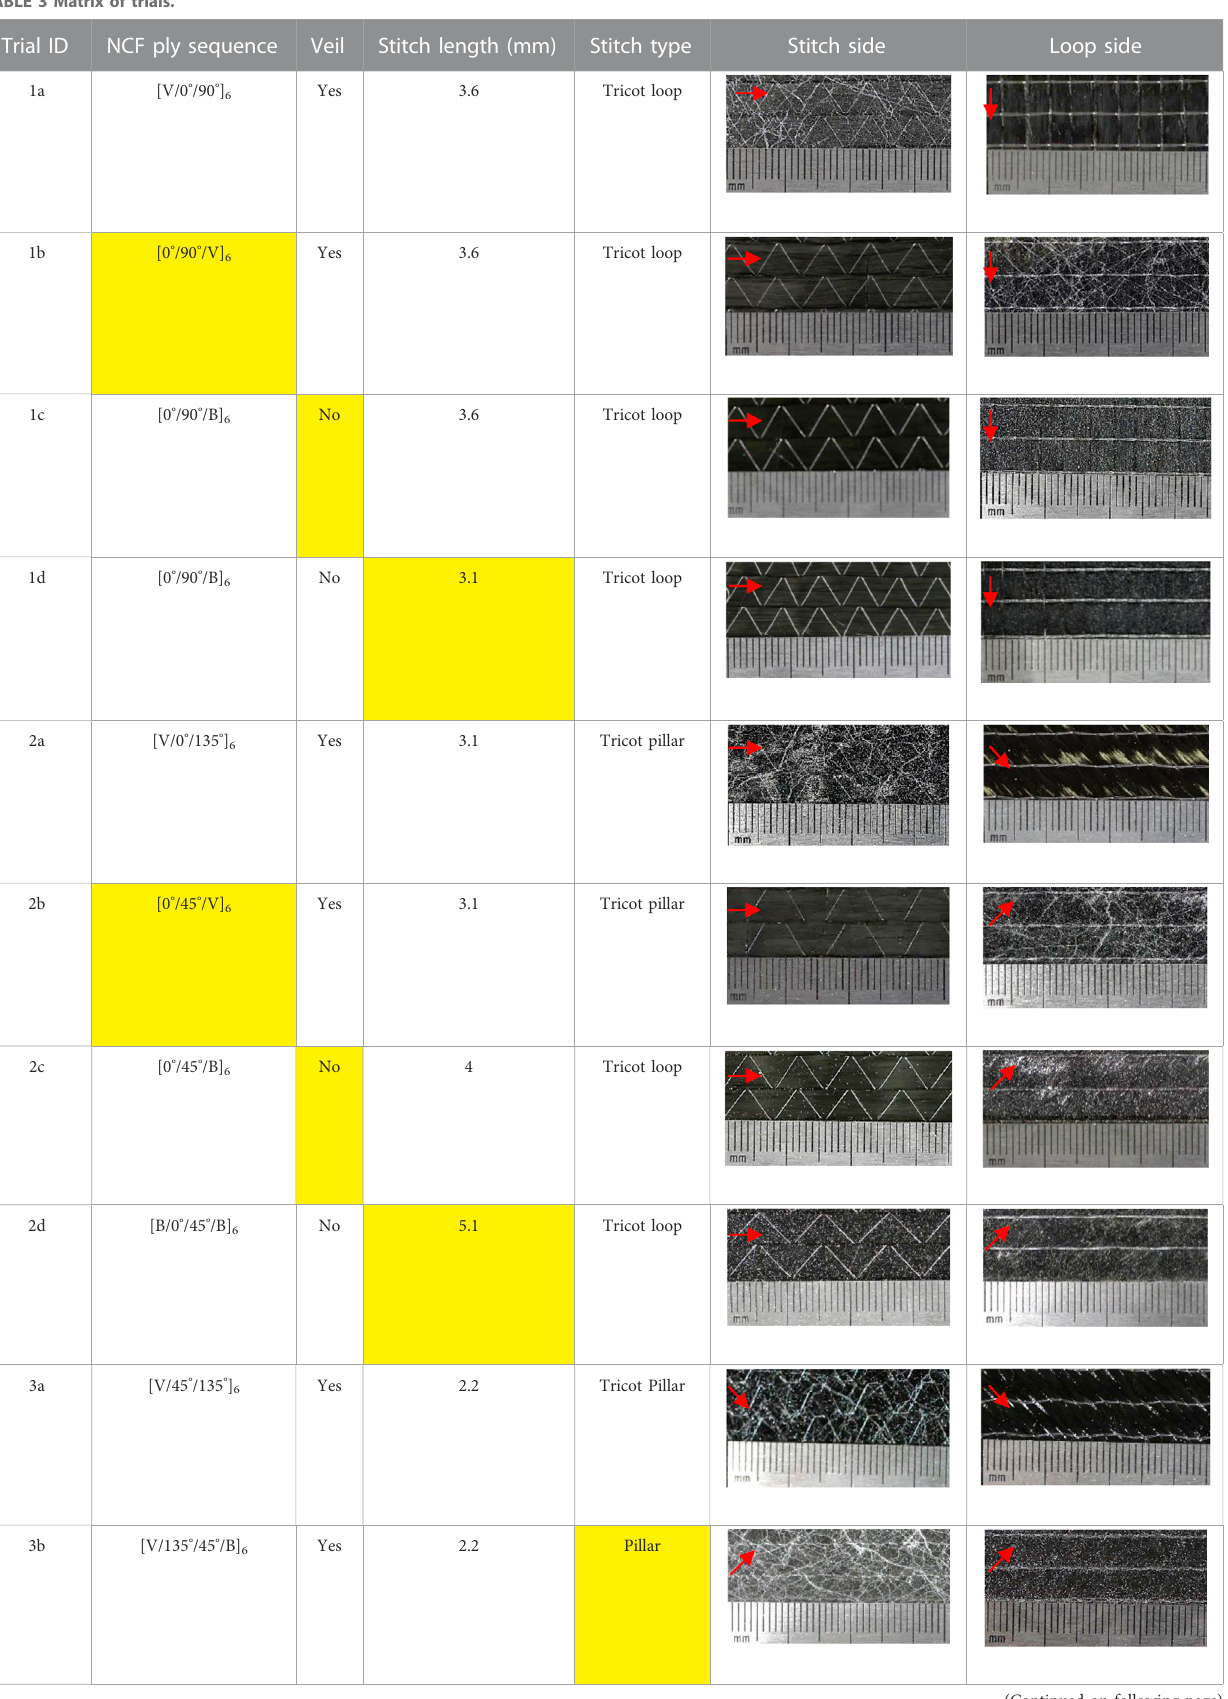
TABLE 3 Matrix of